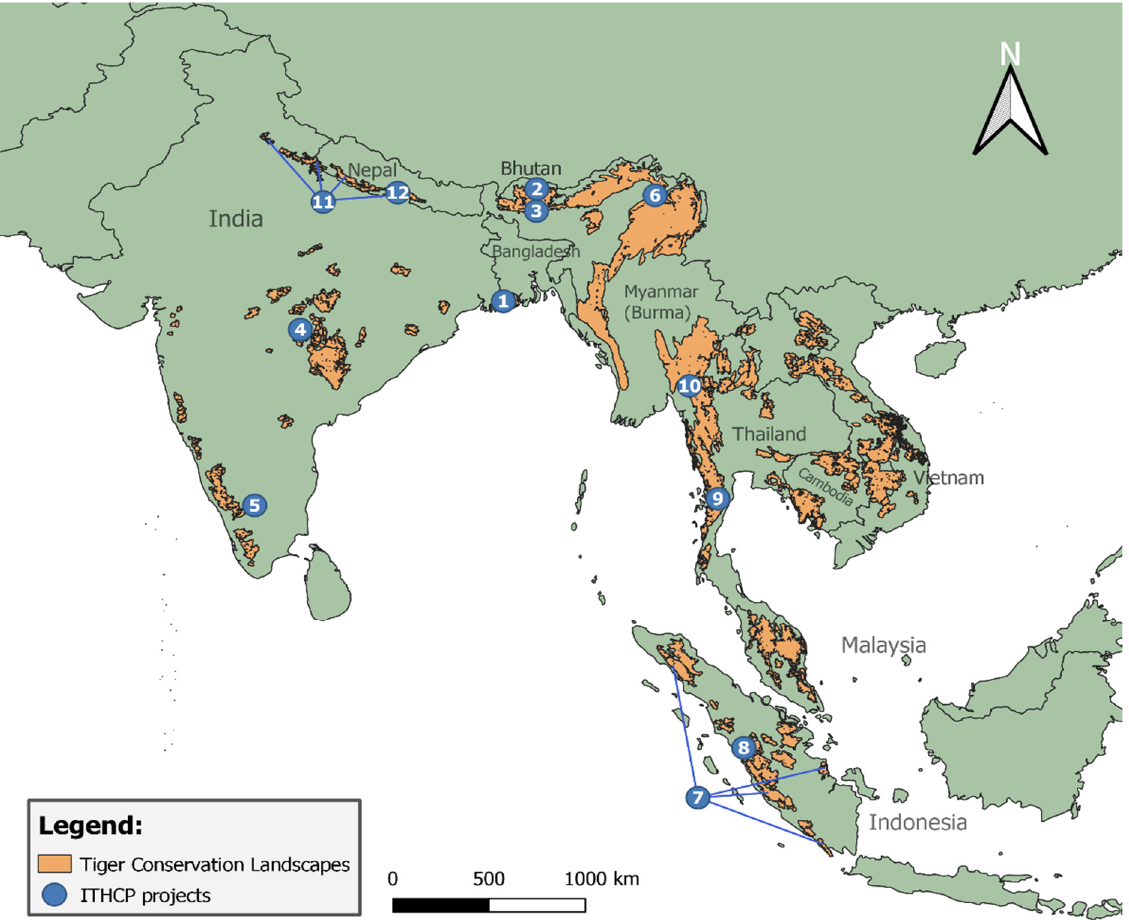
Figure 1. The 12 Integrated Tiger Habitat Conservation Programme (ITHCP) projects across Tiger Conservation Landscapes in 6 countries: Bangladesh, Bhutan, India, Indonesia, Myanmar, and Nepal. Projects 1, 6, 11, and 12 are transboundary projects [21].